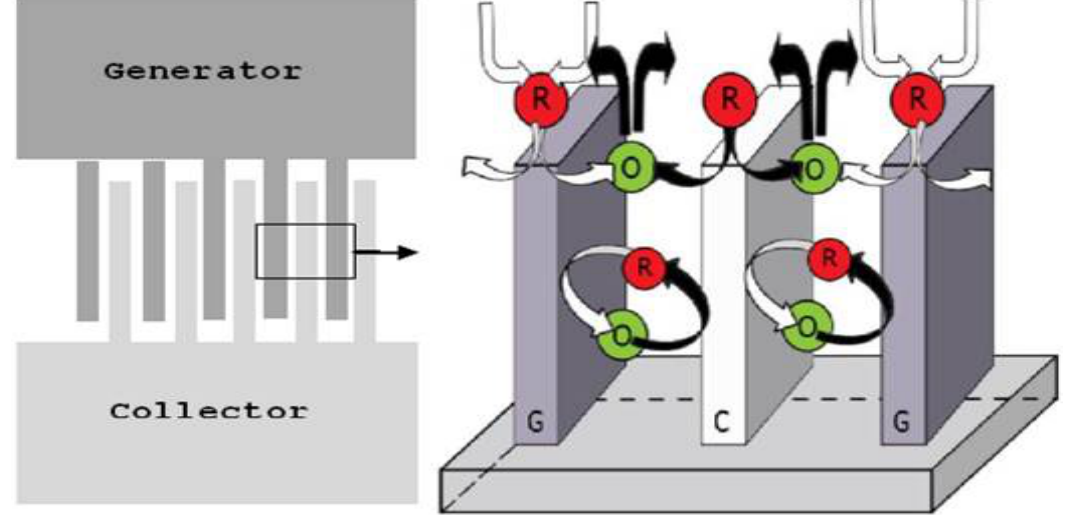
Figure 9. Three-dimensional carbon interdigitated electrode arrays (IDEAs) for redox amplification. For two adjacent electrodes in this configuration that are closely spaced and biased at different potentials, species will undergo oxidation at the electrode with a higher potential or the generator (G), and oxidized species will undergo reduction at the electrode with a lower potential or the collector (C). For G and C electrodes that are in close proximity, redox species can undergo redox cycling multiple times before they diffuse out into the bulk solution. Adapted with permission from [126]. Copyright 2014 American Chemical